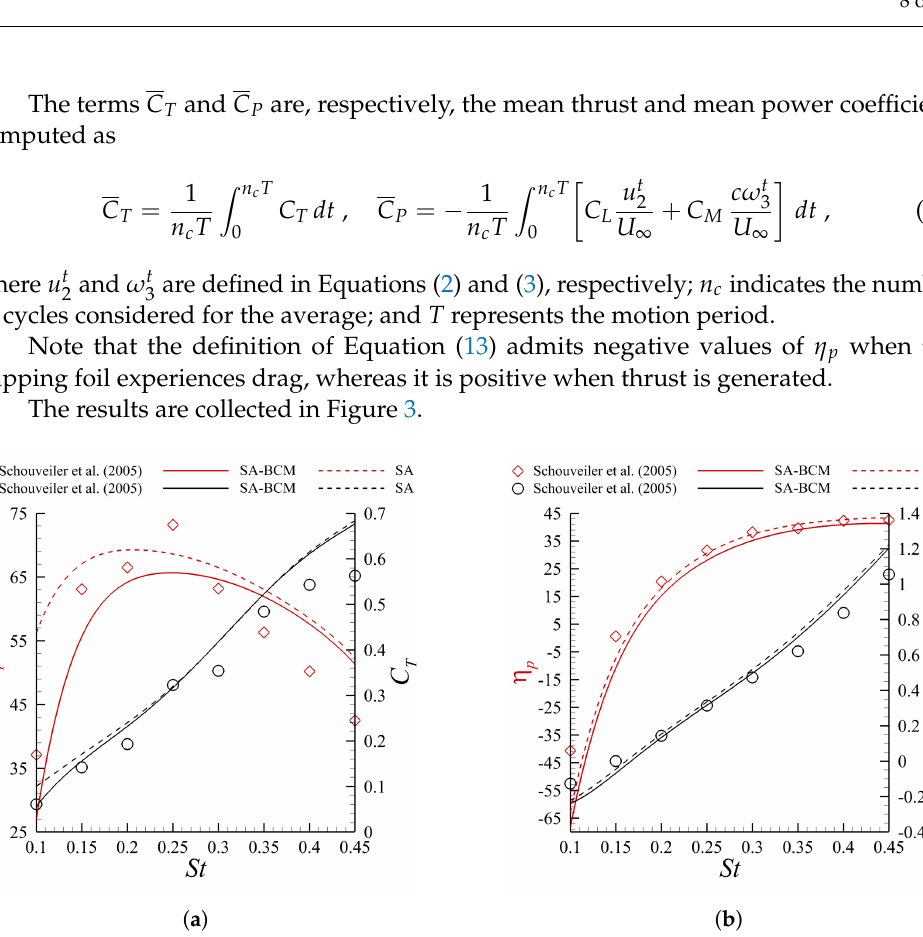
Figure 3. Propulsive efficiency and mean thrust coefficient as a function of the Strouhal number for α max = 15 ◦ ( a ) and α max = 30 ◦ ( b ). Experimental data digitized from